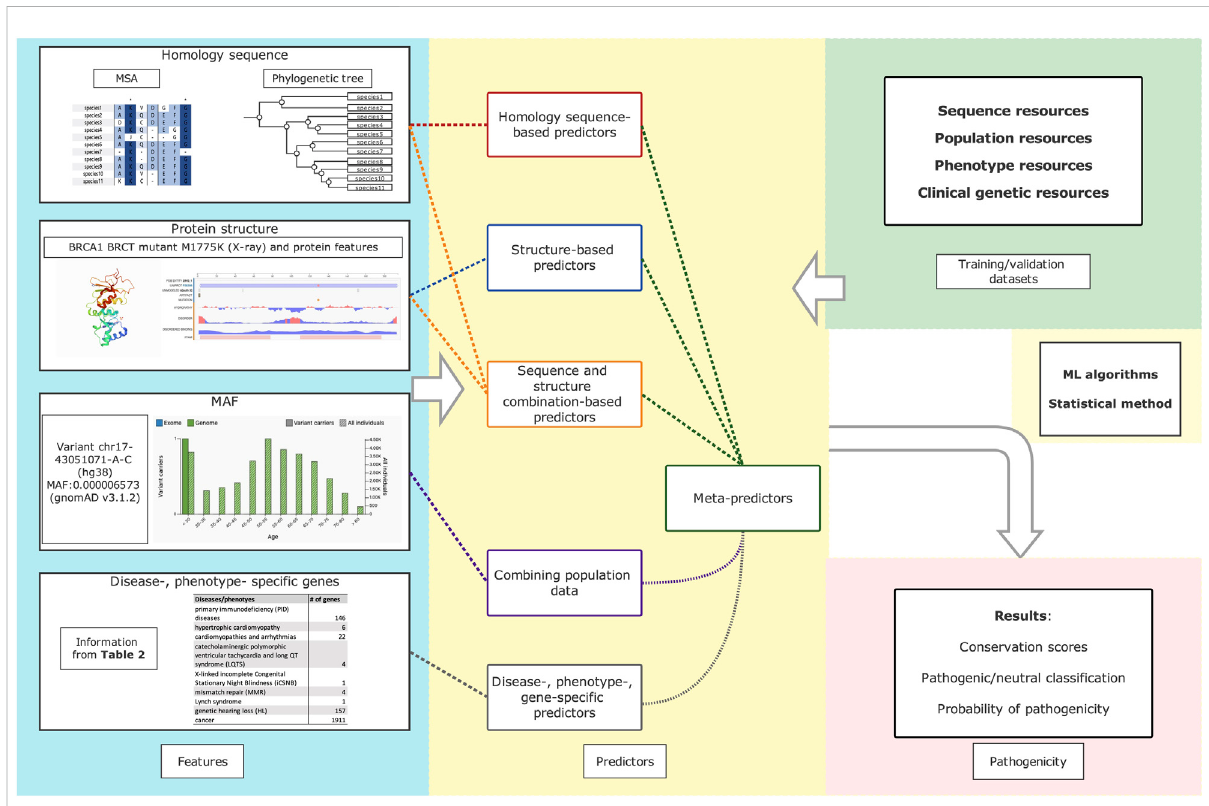
FIGURE 1 Summarized work fl ow of variants impact predictors. Protein structure and protein features of BRCA1 BRCT mutant M1775K are retrived from studies. (Birrane, 2006: Tischkowitz et al., 2008). The minor allele frequency (MAF) information of variant rs41293463 (chr17-43051071-A- C(GRCh38)) was retrived from gnomAD (Genome Aggregation